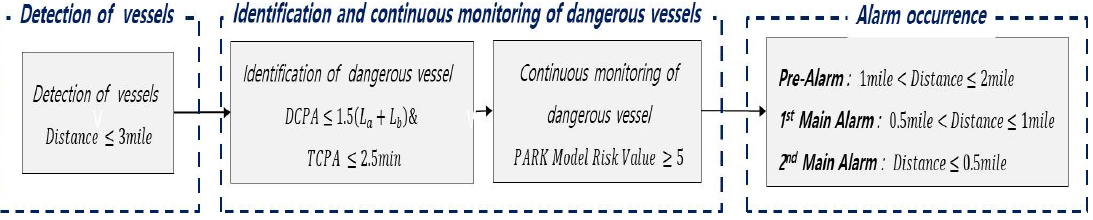
Figure 2. Schematic of collision prevention algorithm.